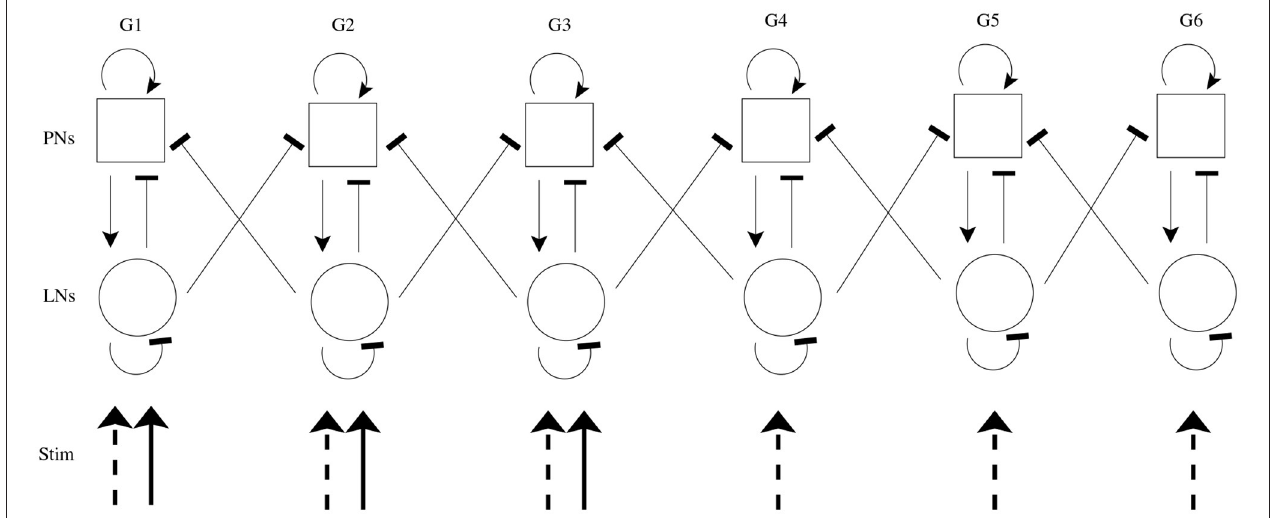
FIGURE 1 | Schematic of model AL network. The model contains 6 glomeruli (columns); squares represent PNs (10 per glomerulus), and circles represent LNs (6 per glomerulus). Arrow heads indicate excitation, while bar heads indicate inhibition. Within a glomerulus, all cell types form synapses with each other (with cell type-specific connection probabilities), while glomerular cross-talk is mediated only via LN → PN synapses (cross-glomerular connection probability is identical for all glomerular pairs). An odor is simulated via delivery of excitatory stimulus current to all cells within a subset of three glomeruli (solid incoming arrows), while mechanosensory input is simulated via delivery of excitatory stimulus current to all cells within all glomeruli (dashed incoming